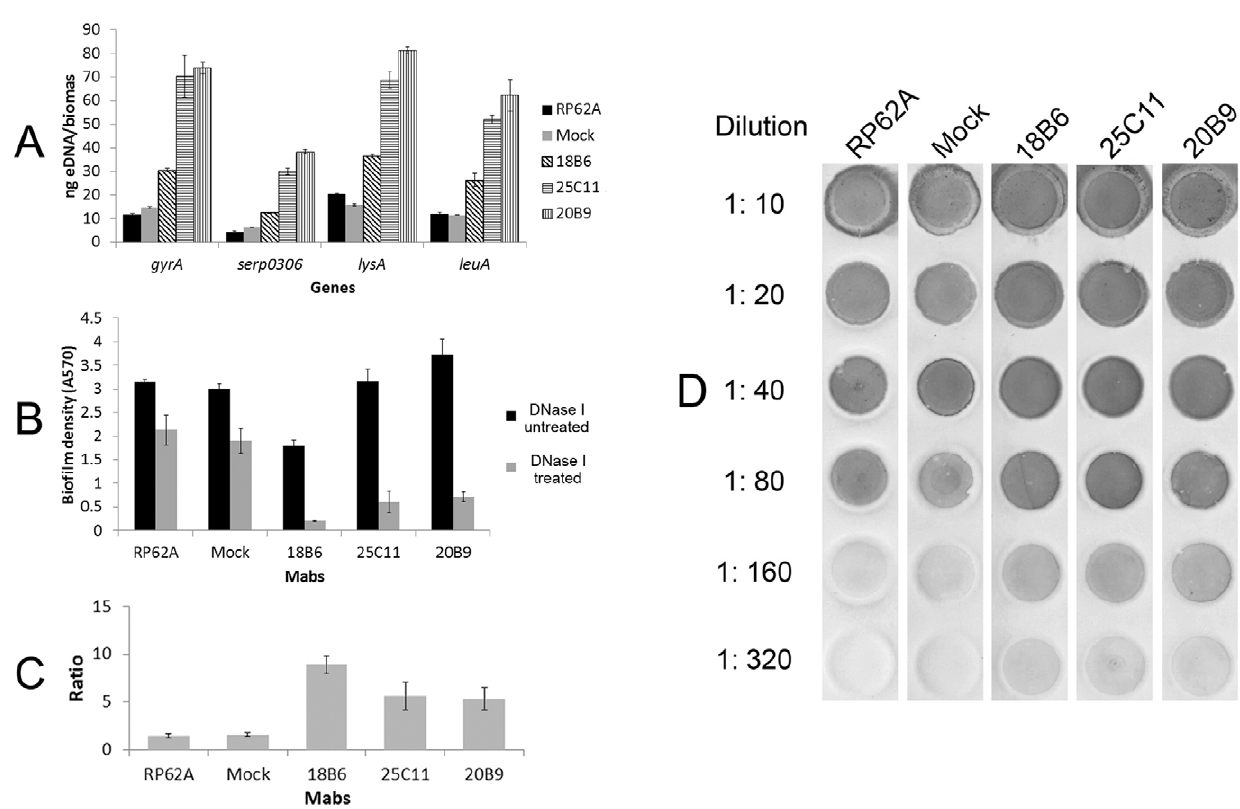
Figure 8. EPS biosynthesis in biofilm of S.epidermidis . (A) Extracellular DNA quantification. Extracellular DNA was isolated from the biofilm matrices of S. epidermidis RP62A, and Q-PCRs of four chromosomal loci ( gyrA (gyrase A), serp0306 (ferrichrome transport ATP-binding protein A), lysA